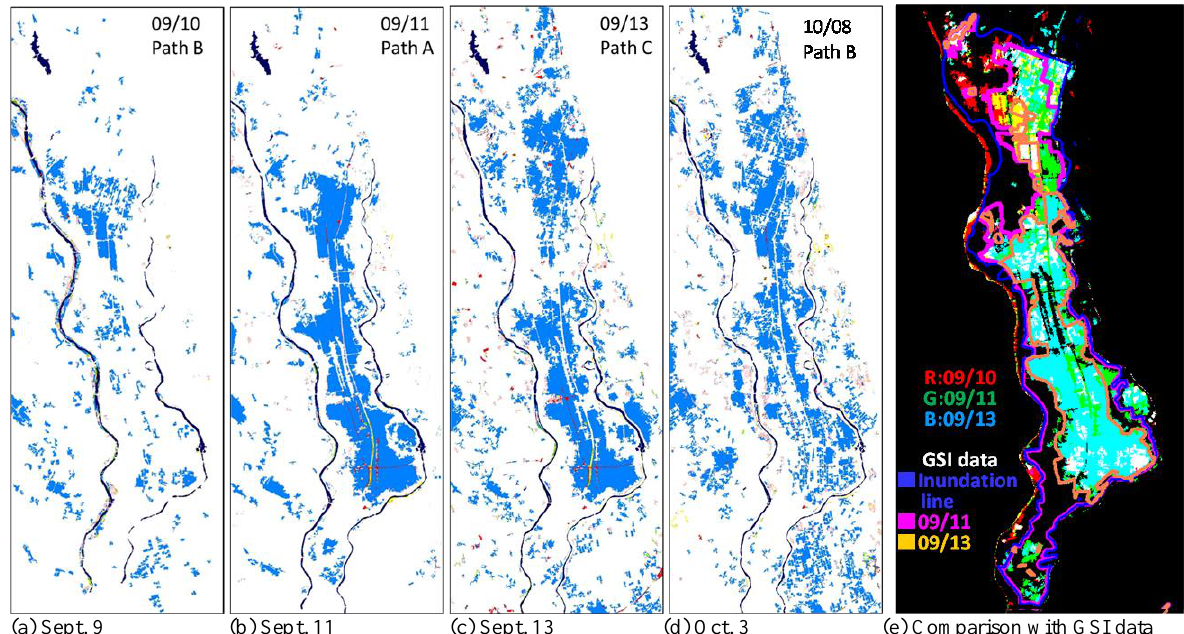
Figure 7. Extracted water areas from the PALSAR-2 images and comparison of the results with the GSI’s visual inspection